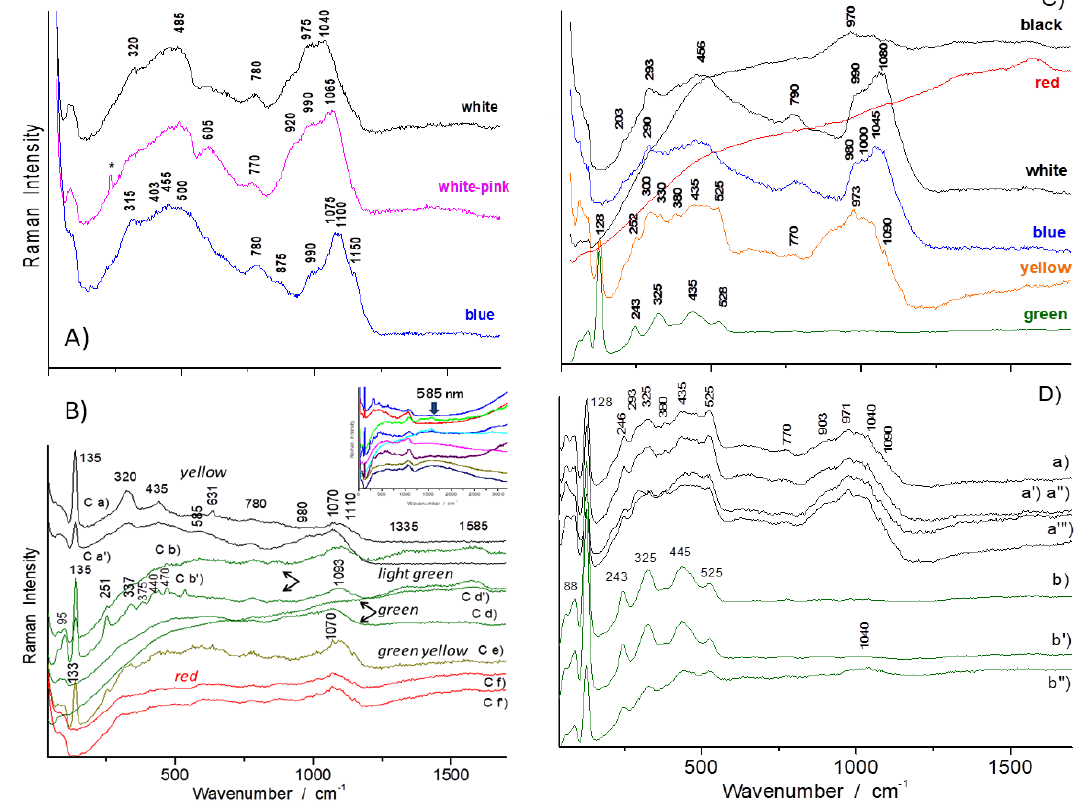
Figure 5. Representative Raman spectra recorded on the cloisonné enamelled F1448C (Kangxi period) tripod (left, A , B ) and the F1501 (Qianlong period) bottle (right, C , D ) for the different coloured areas. The small inserted graph shows the fluorescence peaking at ~585 nm observed for red enamelled areas; ( D ) details; yellow: a to a′′′, green: b to b′′.